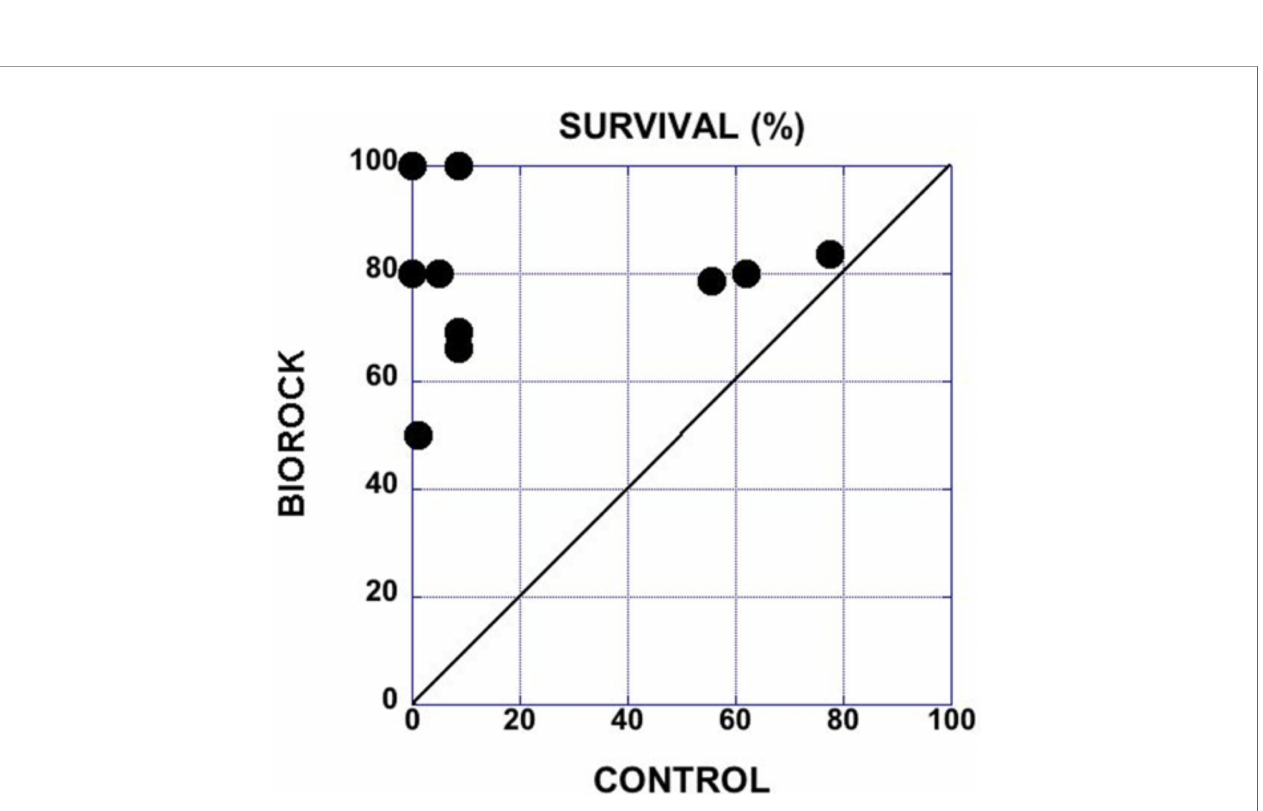
FIGURE 11 | Survival on Biorock versus controls for hard corals, soft corals, oysters, and other marine organisms. Each dot represents comparisons of Biorock versus controls for a different species on a different project under different conditions, from Goreau